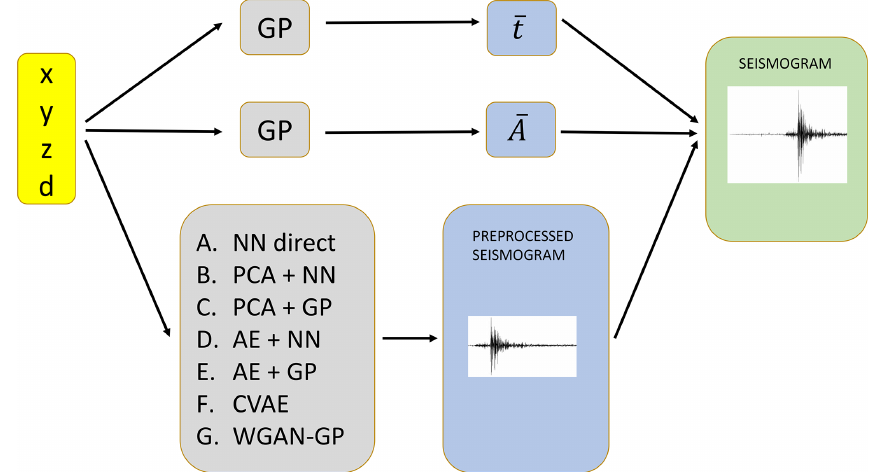
Figure 2. Schematic of the generic framework for seismograms emulation developed in this work. Two Gaussian processes (GP) are trained to learn the preprocessing parameters t and A , described in Sect. 2.1. One out of seven algorithms (described schematically in Fig. 3 and in detail in Sect. 2.2) is chosen to generate a preprocessed seismogram. Finally, the combination of this learnt preprocessed seismogram and the learnt t and A gives the output seismogram corresponding to the coordinates (x,y,z,d) (we augment the spatial coordinates (x,y,z) with the distance d from the receiver, since we noticed that it improves the accuracy of the trained